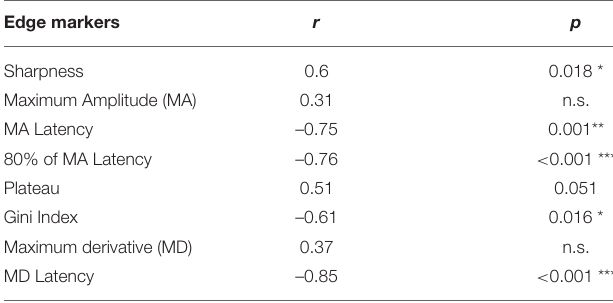
TABLE 2 | Correlation coefficients between ITPC1 and edge markers.